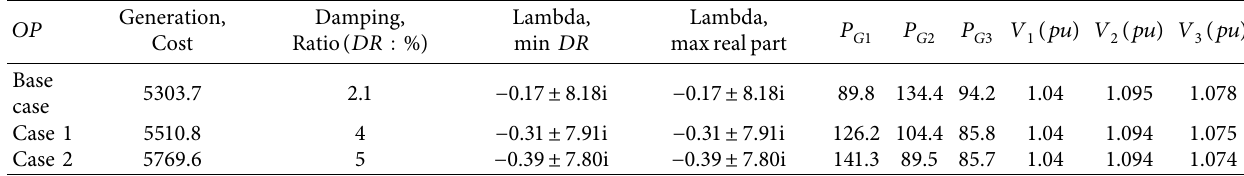
Table 1: Results of the proposed method for IEEE 9-bus system.